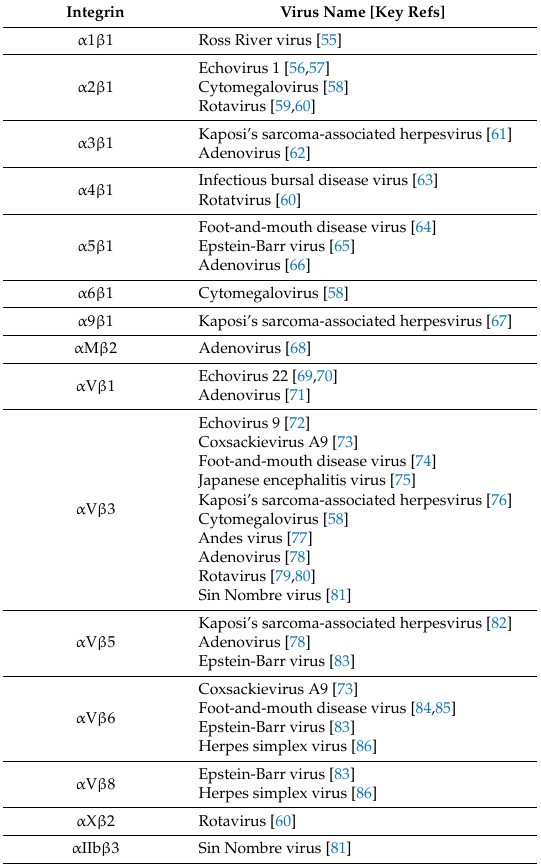
Table 2. Selected integrin binding by